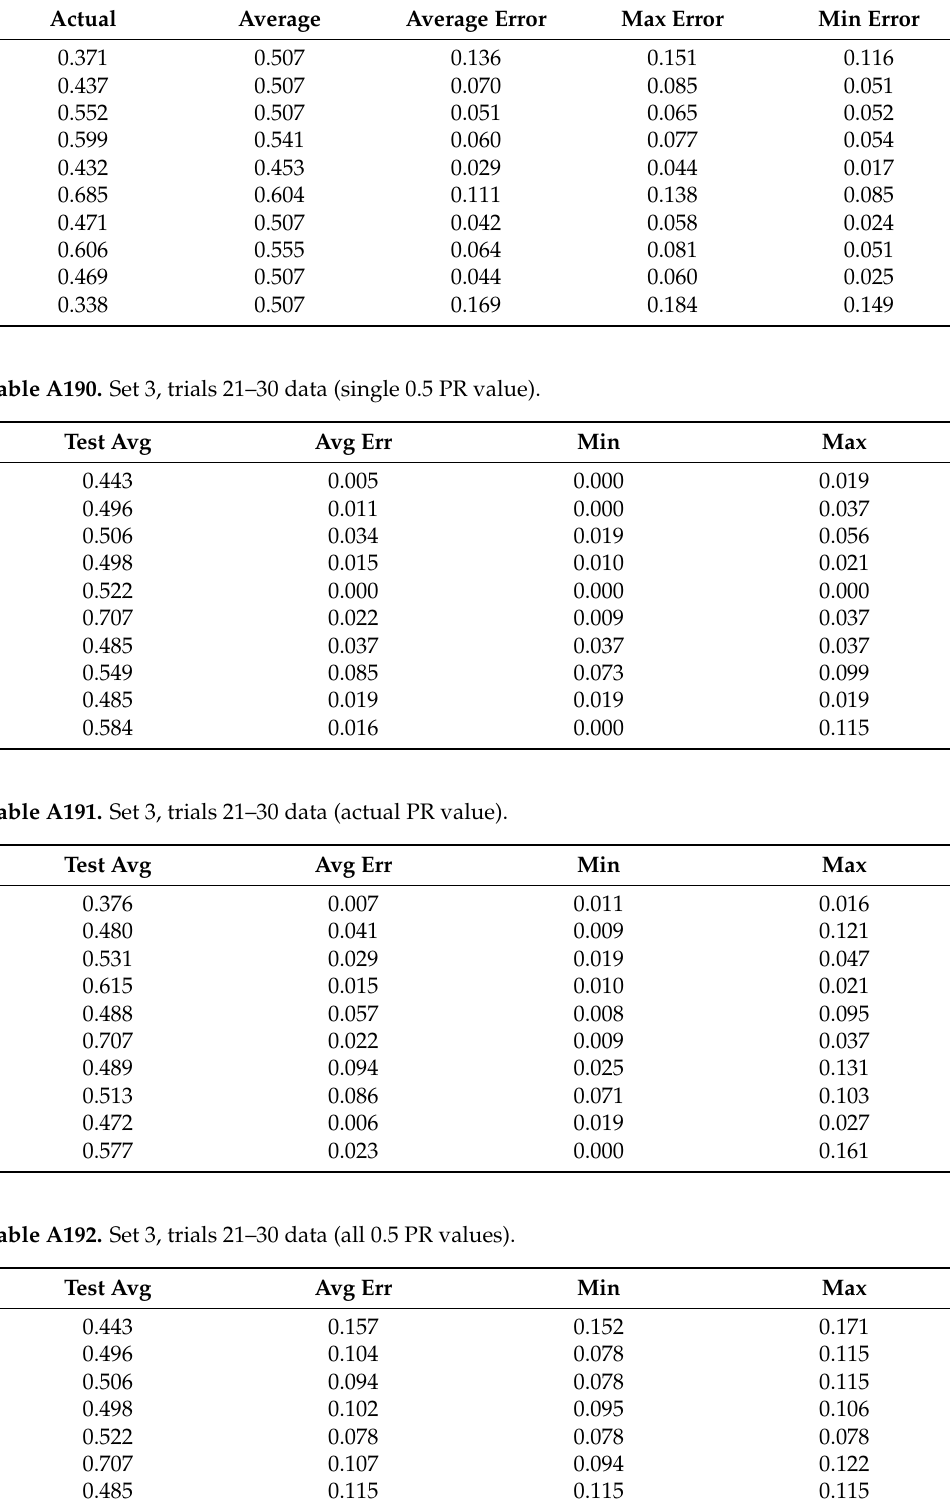
Table A189. Set 3, trials 21–30 data (average actual PR values).